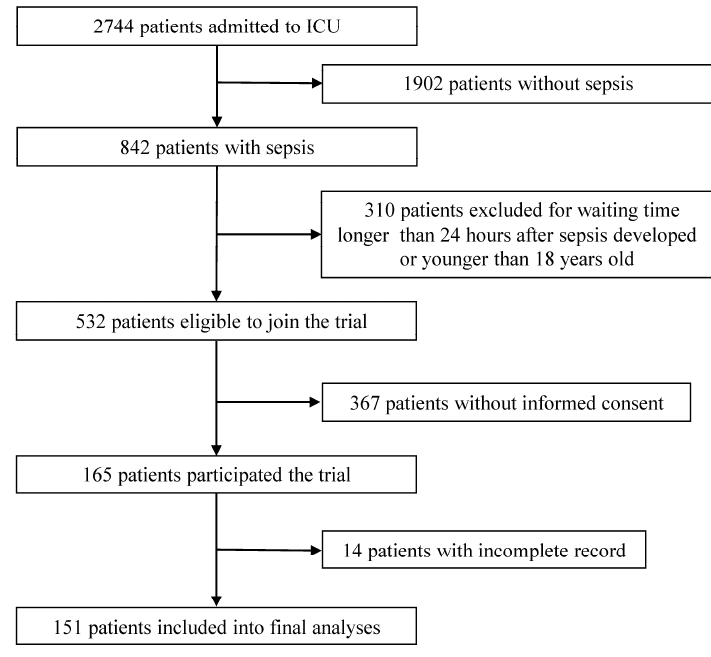
Figure 1. Patient recruitment and